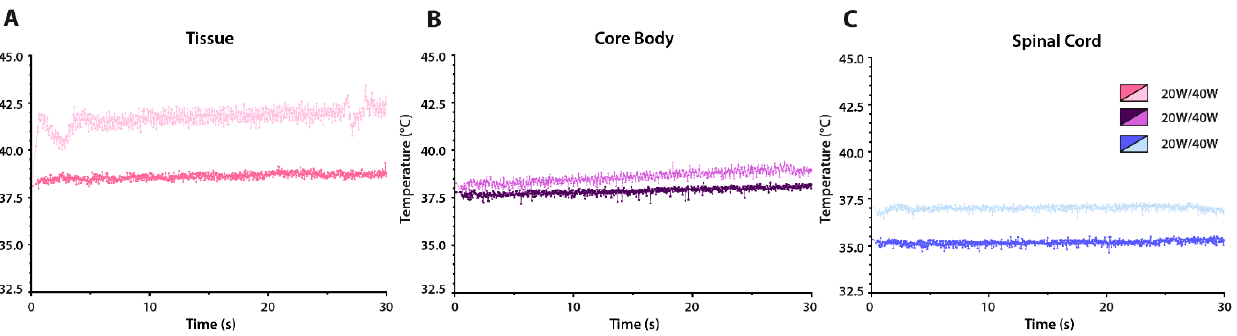
Figure 11. In vivo temperature profiles in the cylindrical heating device based on two input powers (20 and 40 W) for 30 s. ( A ) The heating profiles as measured with thermocouples within the target tissue; ( B ) temperature profiles within the core body; and ( C ) temperature profiles near the spinal cord.